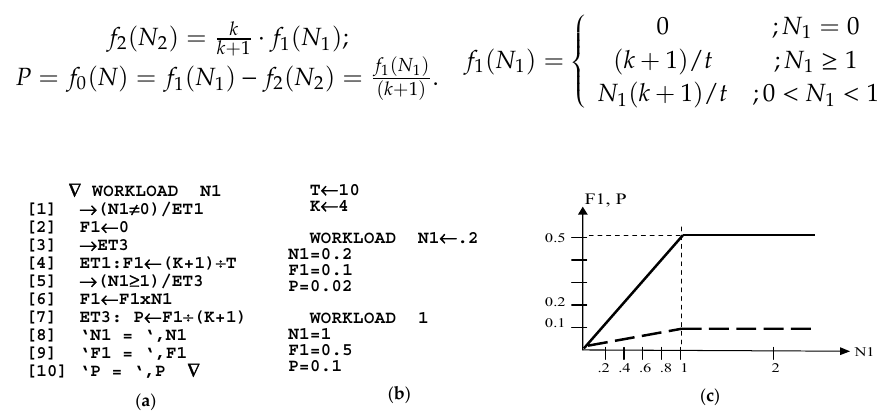
Figure 2. A simple example for analytical model investigation by using APL2—( a ) program code, ( b ) model execution, ( c ) results interpretation.